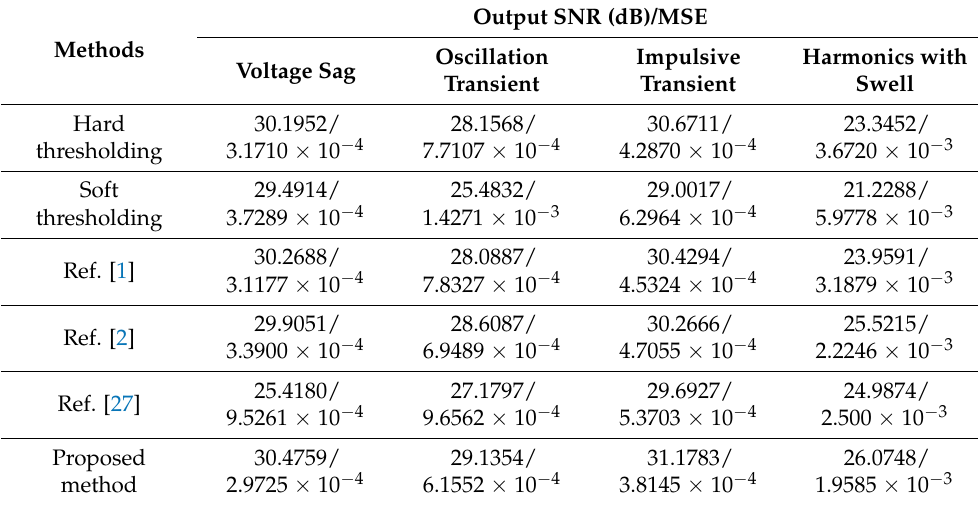
Figure 7. ( a ) Noiseless harmonics with swell; ( b ) harmonics with swell and a SNR of 20 dB; ( c ) hard thresholding denoising; ( d ) soft thresholding denoising; ( e ) denoising following the method de- scribed in Ref. [1]; ( f ) denoising following the method described in Ref. [2]; ( g ) denoising following the method described in Ref. [27]; ( h ) denoising following the proposed method processing.